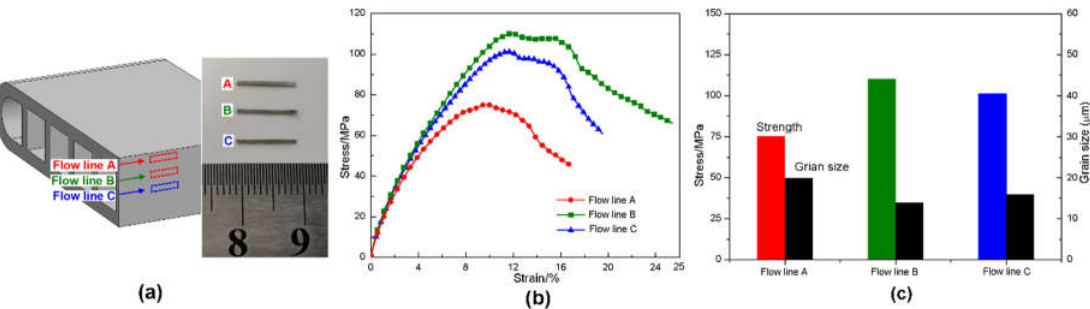
Figure 14. Tensile tests on specimens at different flow lines: ( a ) sampling position; ( b ) engineering stress-strain curves; and ( c ) ultimate